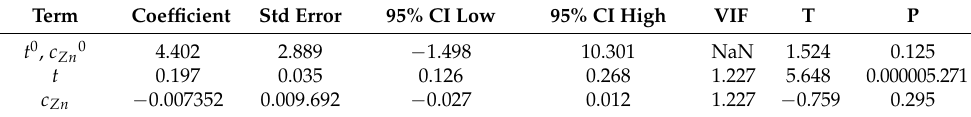
Table 6. Statistical characteristics of the linear regression by two variables for the mass of